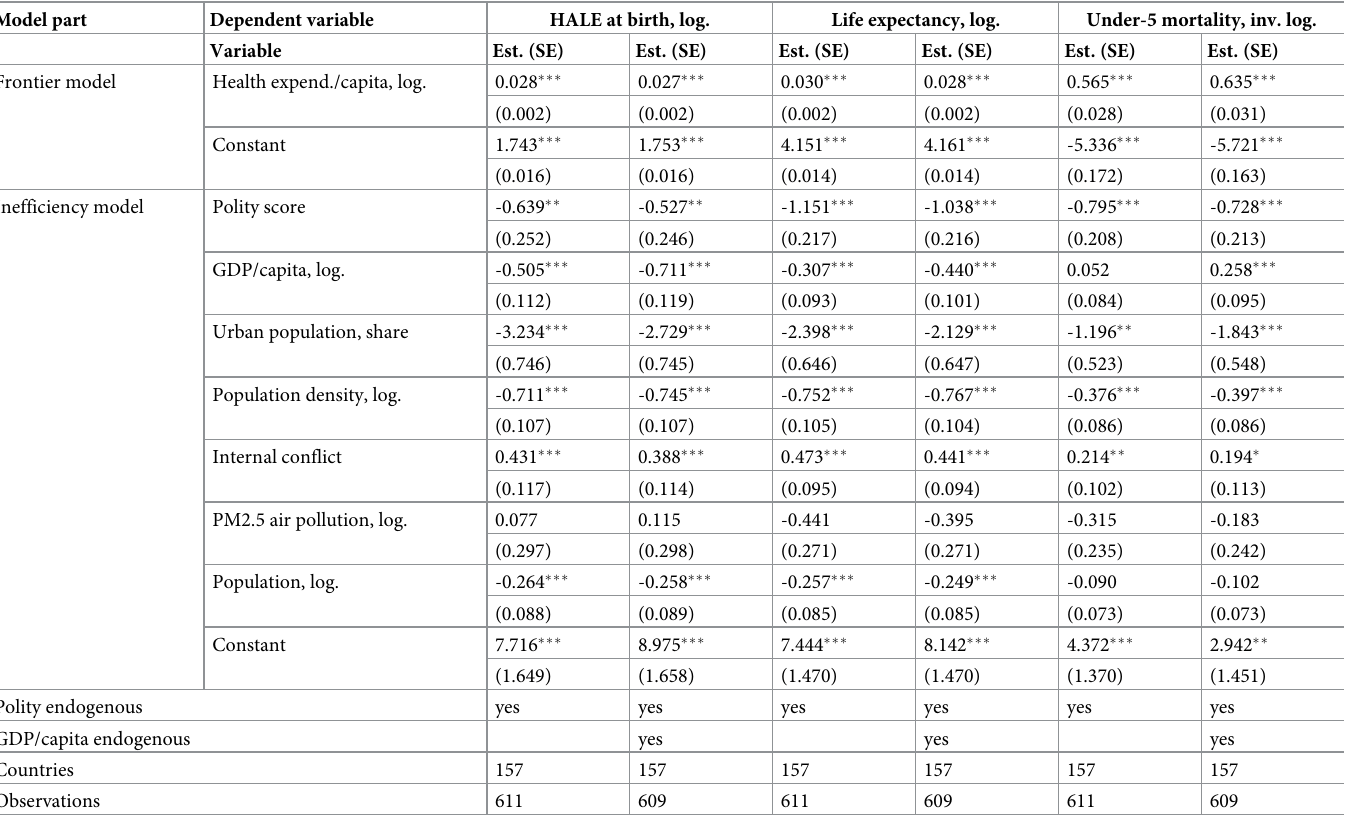
Table 6. SFA results accounting for endogeneity of democracy and GDP per capita. Model